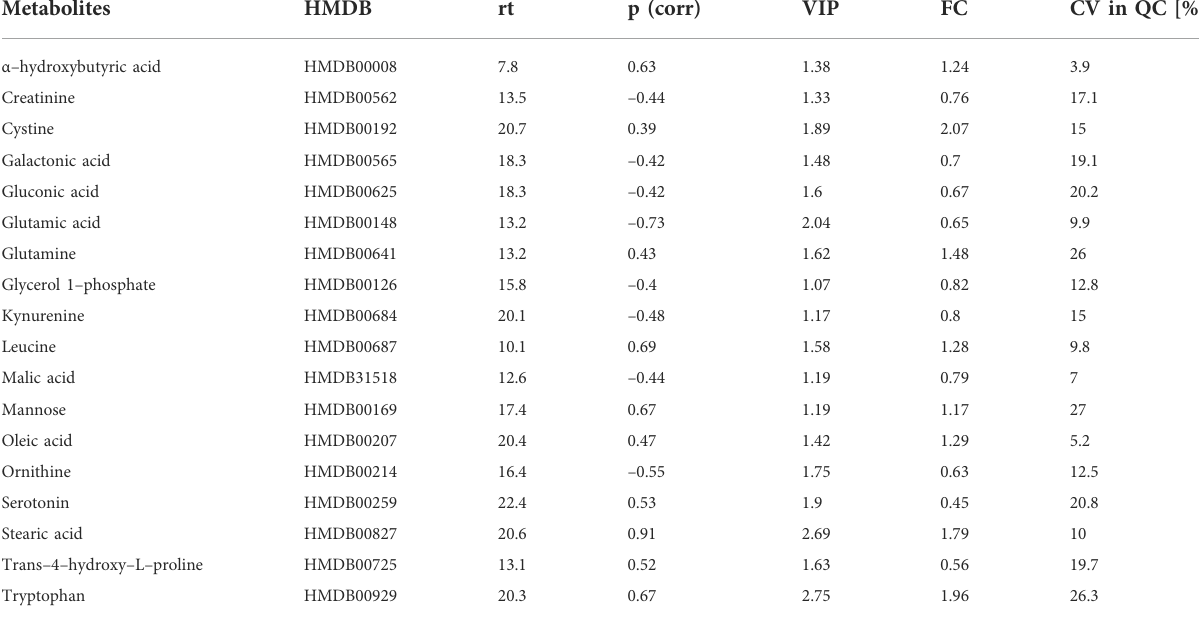
TABLE 6 Statistically signi fi cant changes for MDMs detected in serum. Metabolites checked in the Human Metabolome Database (HMDB) (http:// www.hmdb.ca access: 20 th April 2022); rt, retention time (minutes); p (corr) — predictive loading values in the OPLS-DA, VIP — variable importance in projection; CV, coef fi cient of variation of the metabolites in the QC samples; FC, fold change in the comparison (PreDiab vs.